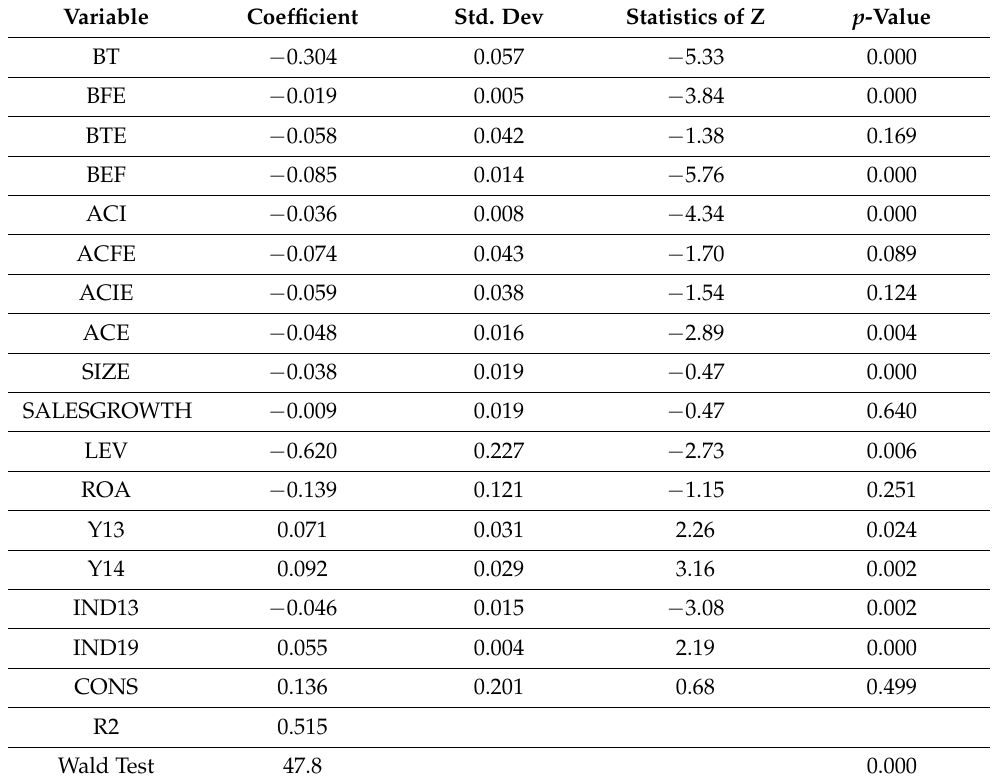
Table 20. The outcomes of evaluating model two by the random effects method.